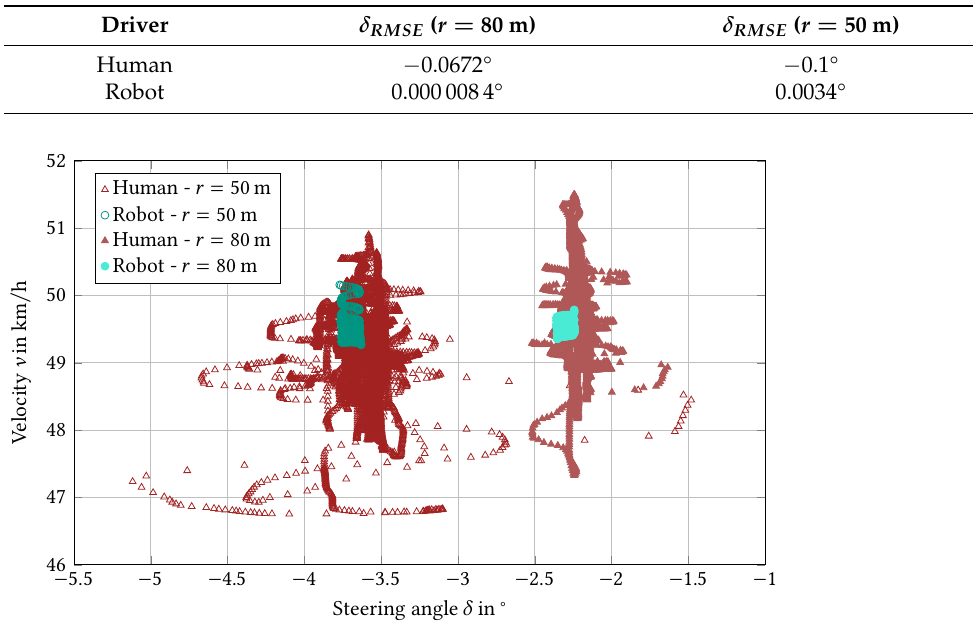
Figure 9. Velocity as a function of the steering angle from measurements of the human driver and the driving robot in different steering